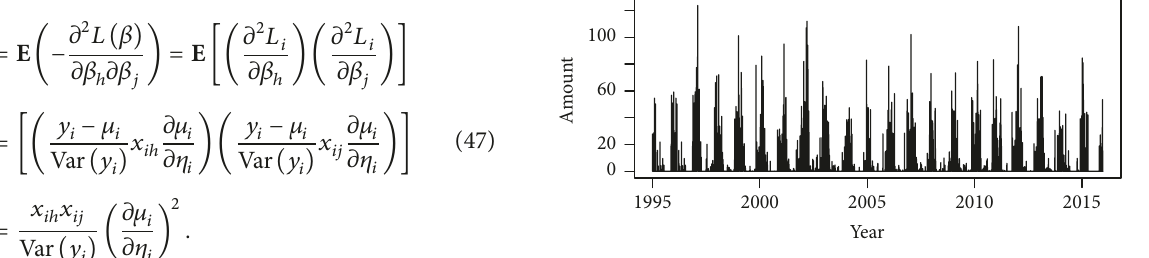
Figure 1: Daily rainfall amount for Balaka district.